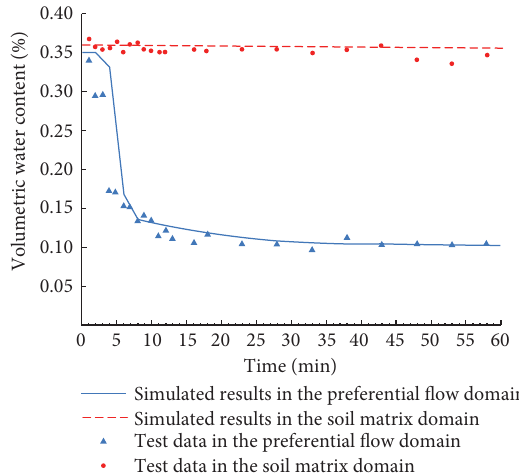
Figure 10: Measured and simulated water contents at 35cm depth in the matrix and preferential flow domains.